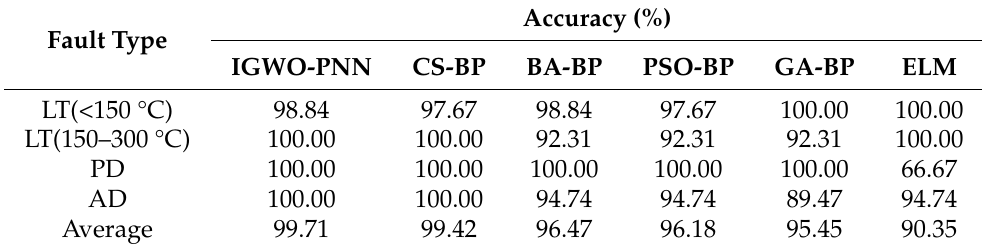
Table 7. Results of the third set of comparative